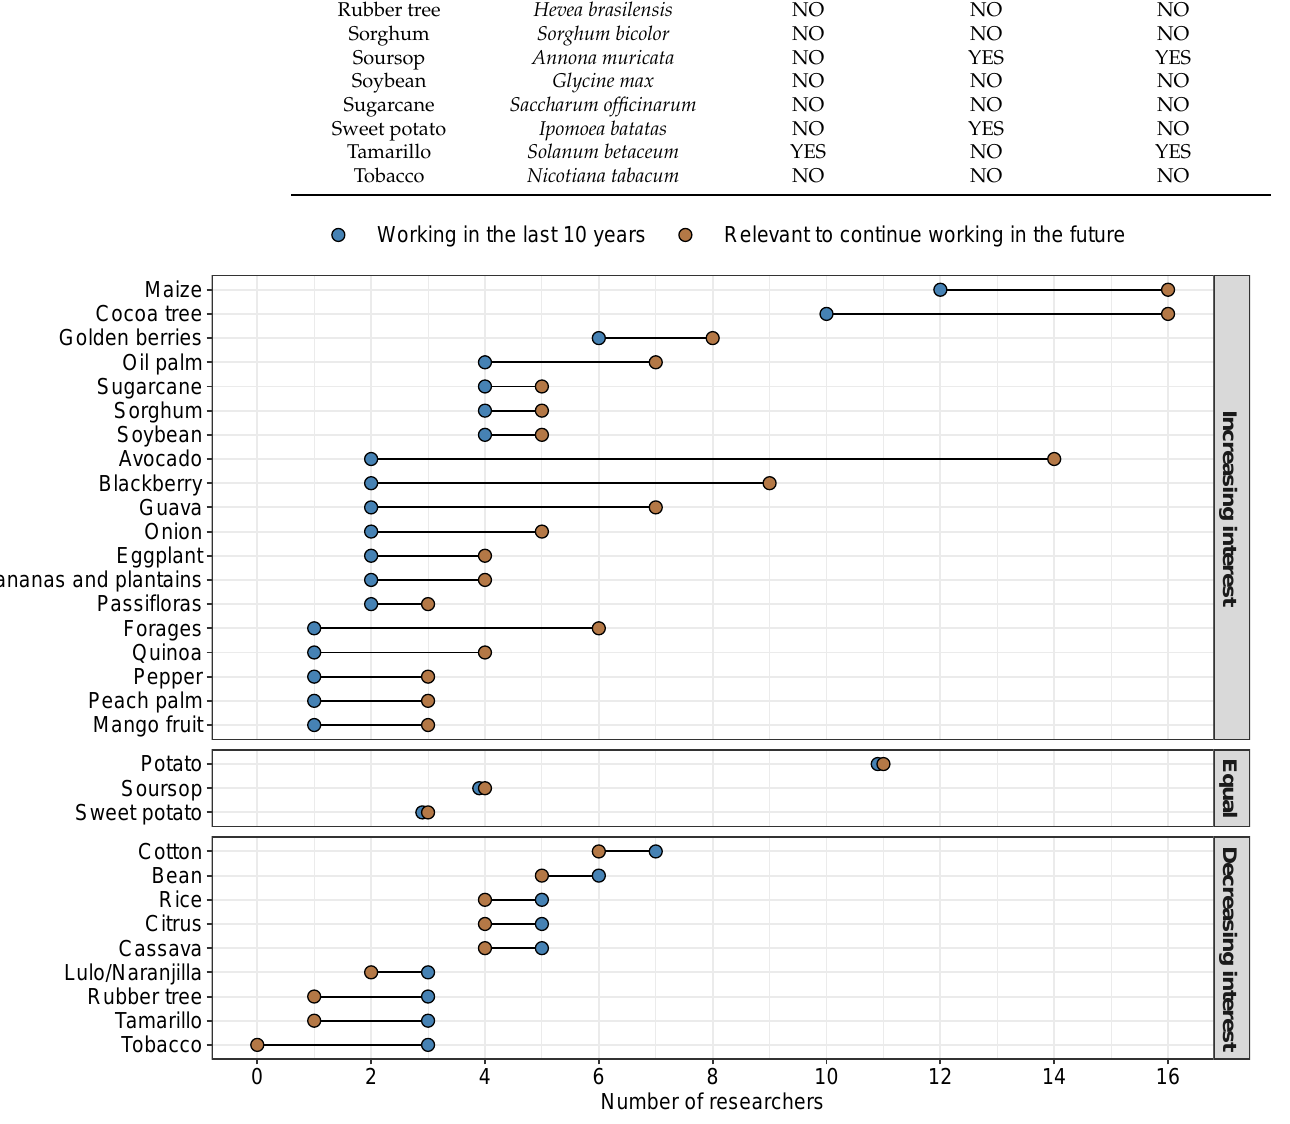
Figure 2. List of crops worked on by surveyed A GROSAVIA researchers in the last ten years (blue dots) and those considered relevant to continue working with in the future (yellow dots). Past and future research interests show three distinct patterns: crops with increasing interest for future work (increasing interest), crops with similar interest historically and in the future (equal), and crops with decreasing interest in the future (decreasing